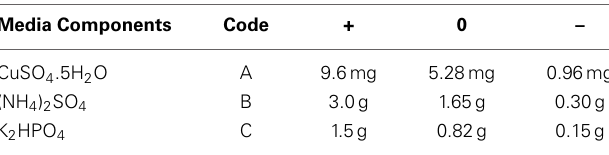
Table 4 | Coded and corresponding actual levels of selected variables for Box-Behnken Design.